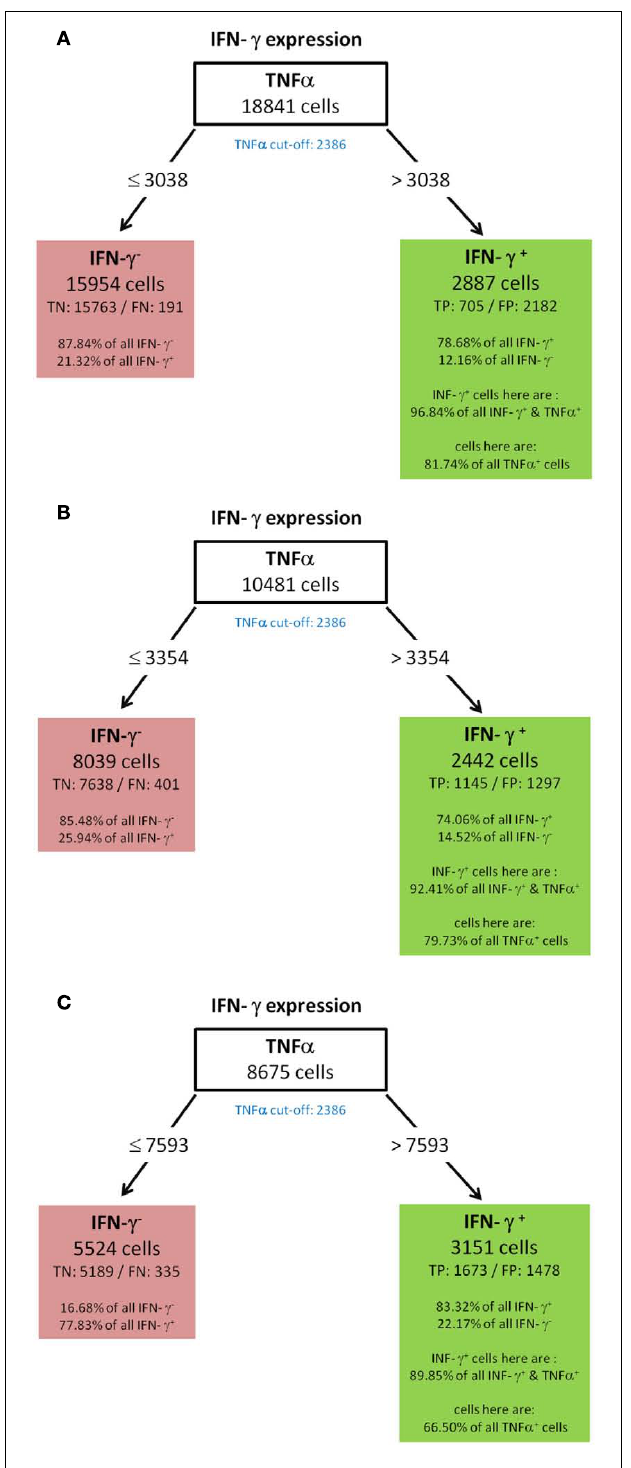
FIGURE 10 | IFN- γ (A)WT-day 9, (B) KO-day 9, (C) KO-day 21.